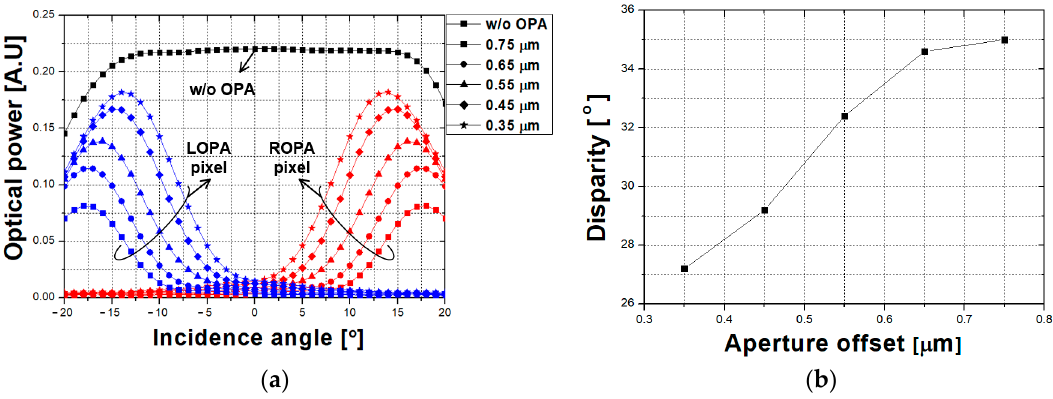
Figure 5. Optical simulation results that demonstrate ( a ) the variations in optical power with the incidence angle as a function of the aperture offset and ( b ) the disparity according to the aperture offset.